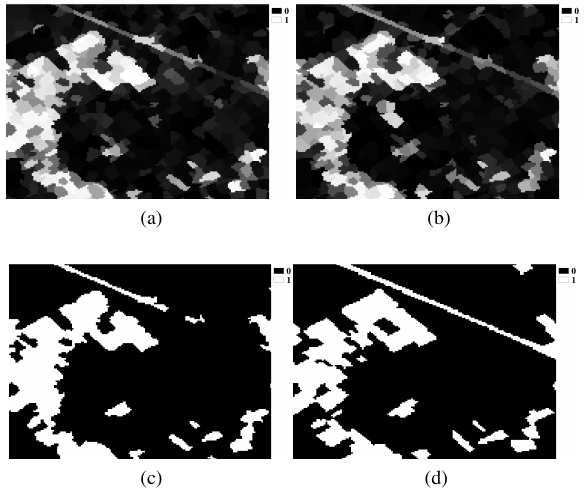
Figure 5: (a) Classification results for ascending stack (b) Classi- fication results for descending stack (c) Combined classification